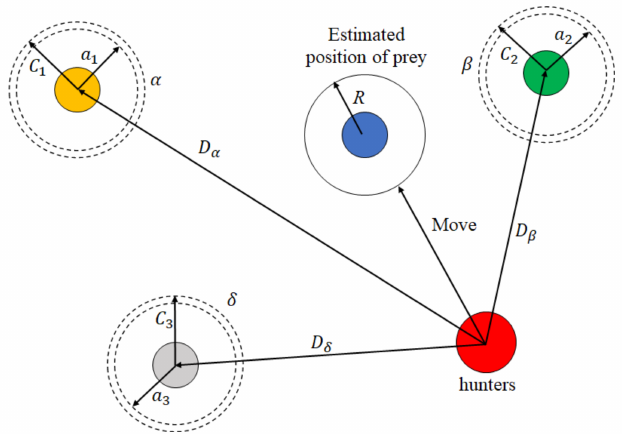
Figure 4. Position update in GWO.